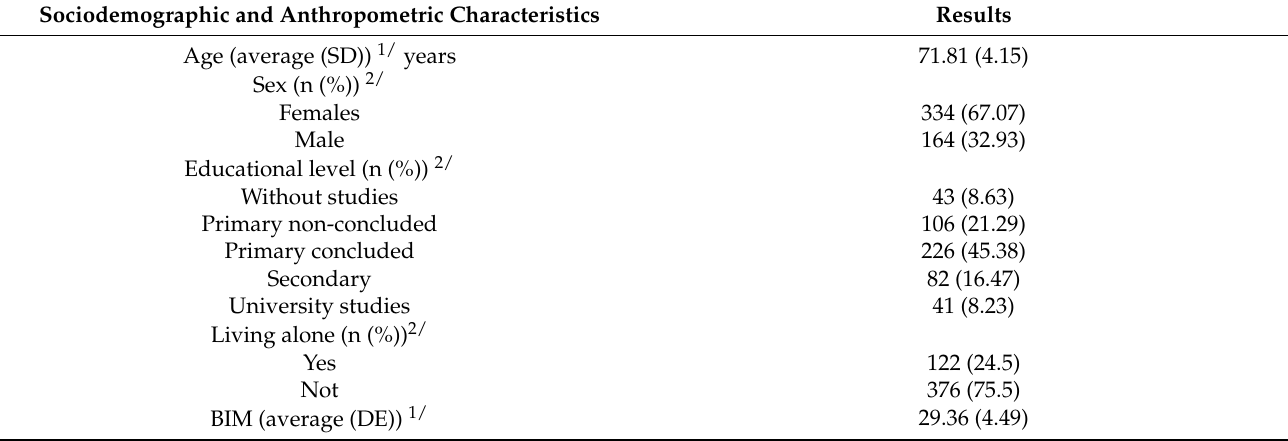
Table 1. Sociodemographic and anthropometric characteristics. Sociodemographic and Anthropometric